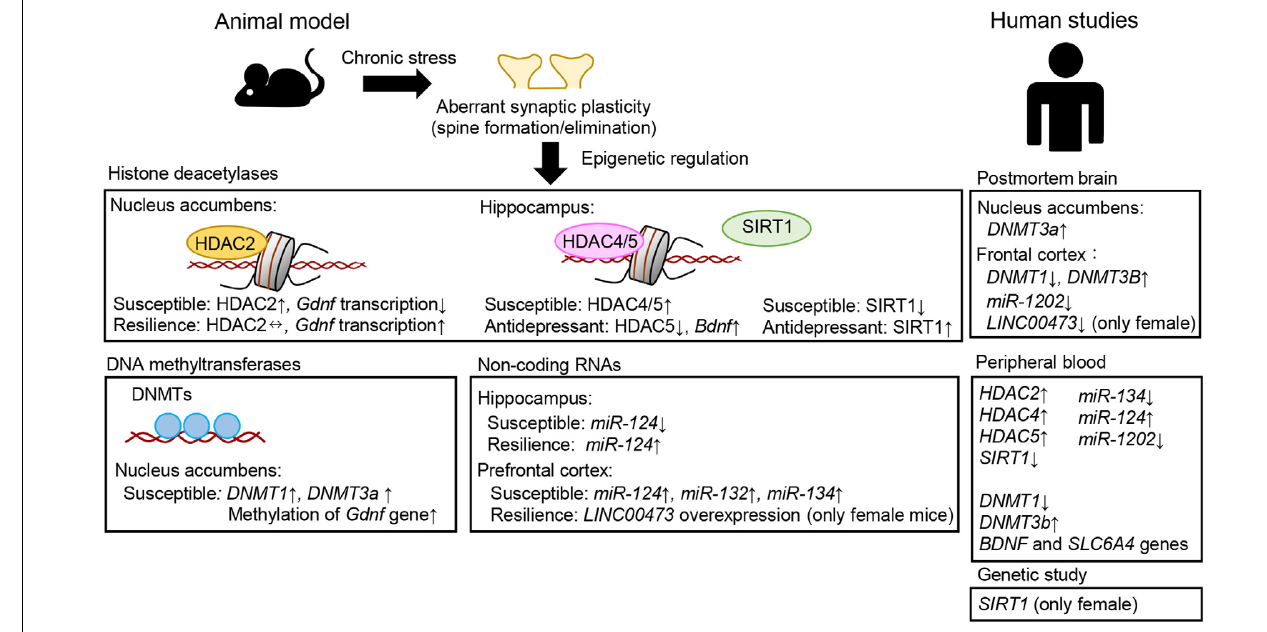
FIGURE 3 | Examples of aberrant epigenetic modifications associated with neuroplasticity, stress, and depression observed in patients with major depressive disorder and/or suicide victims and in animal models of